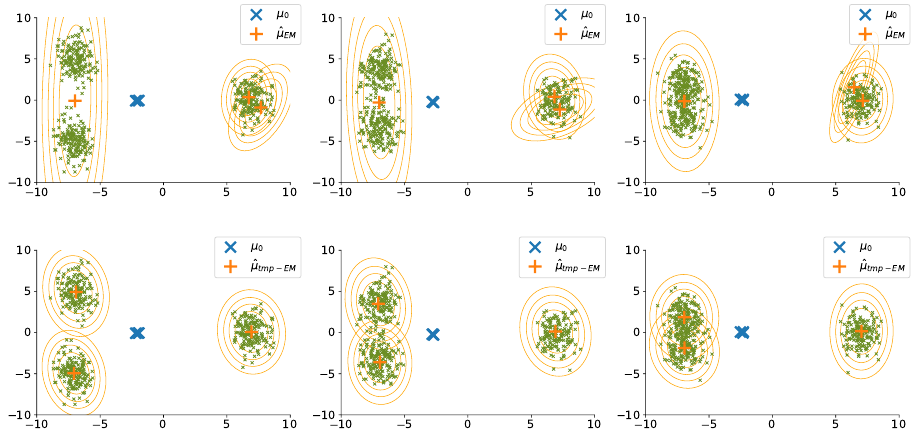
Figure 5. Typical final positioning of the centroids by EM (first row) and tmp-EM with oscillating profile (second row) when the initialisation is made at the barycenter of all data points (blue crosses). The three columns represent the three gradually more ambiguous parameter sets. Each figure represents the positions of the estimated centroids after convergence of the EM algorithms (orange cross), with their estimated covariance matrices (orange confidence ellipses). In each simulation, 500 sample points were drawn from the real GMM (small green crosses). In those example, tmp-EM managed to correctly identify the position of the three real centroids.